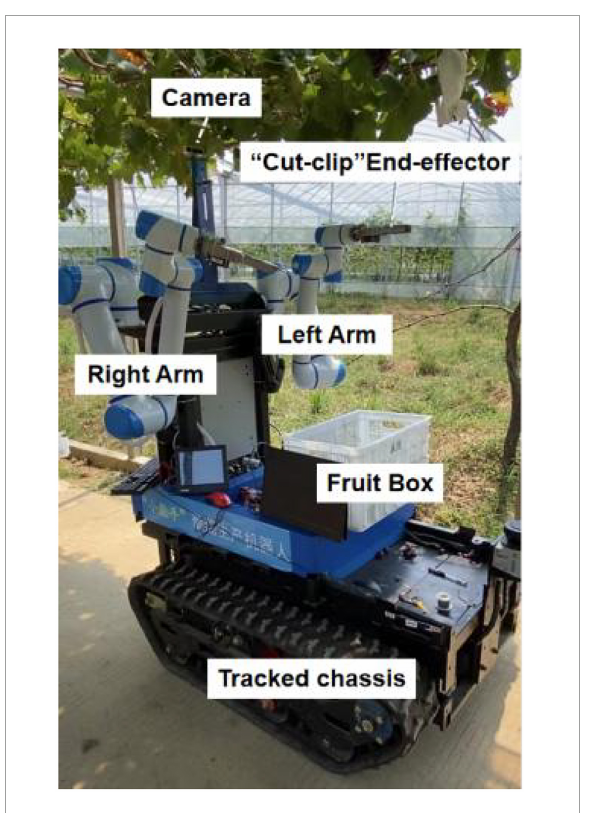
of 2.0 m, a width of 2.5 m, and a trellis length of 30